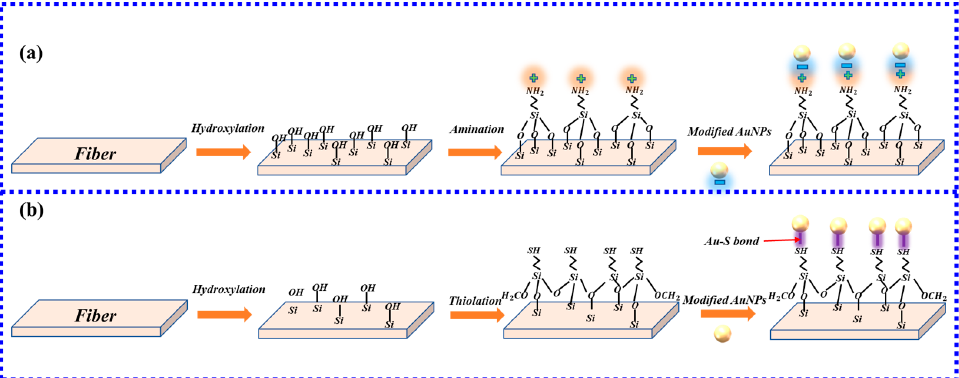
Figure 3. ( a ) aminosilanization process; ( b ) mercaptosilane modified method’s process.